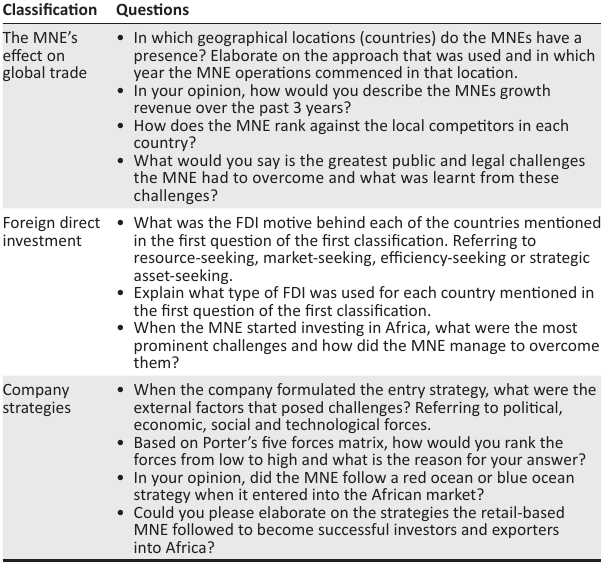
TABLE 1: Interview